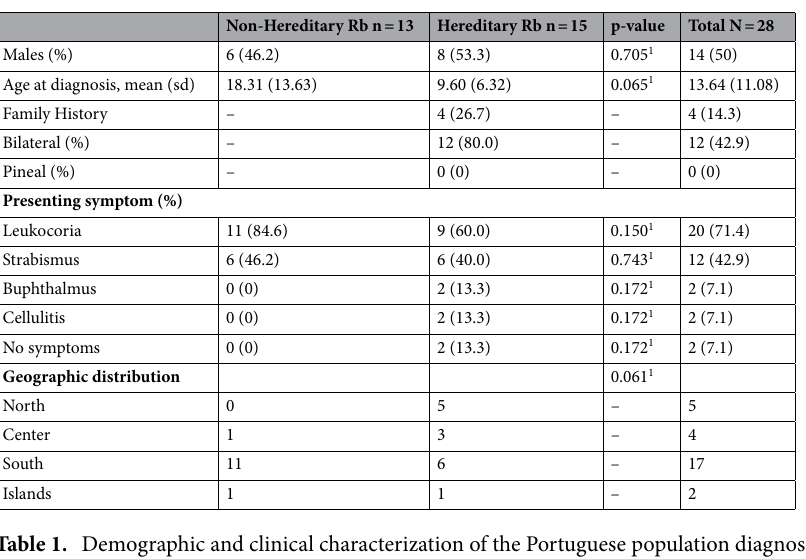
Table 1. Demographic and clinical characterization of the Portuguese population diagnosed with Retinoblastoma.